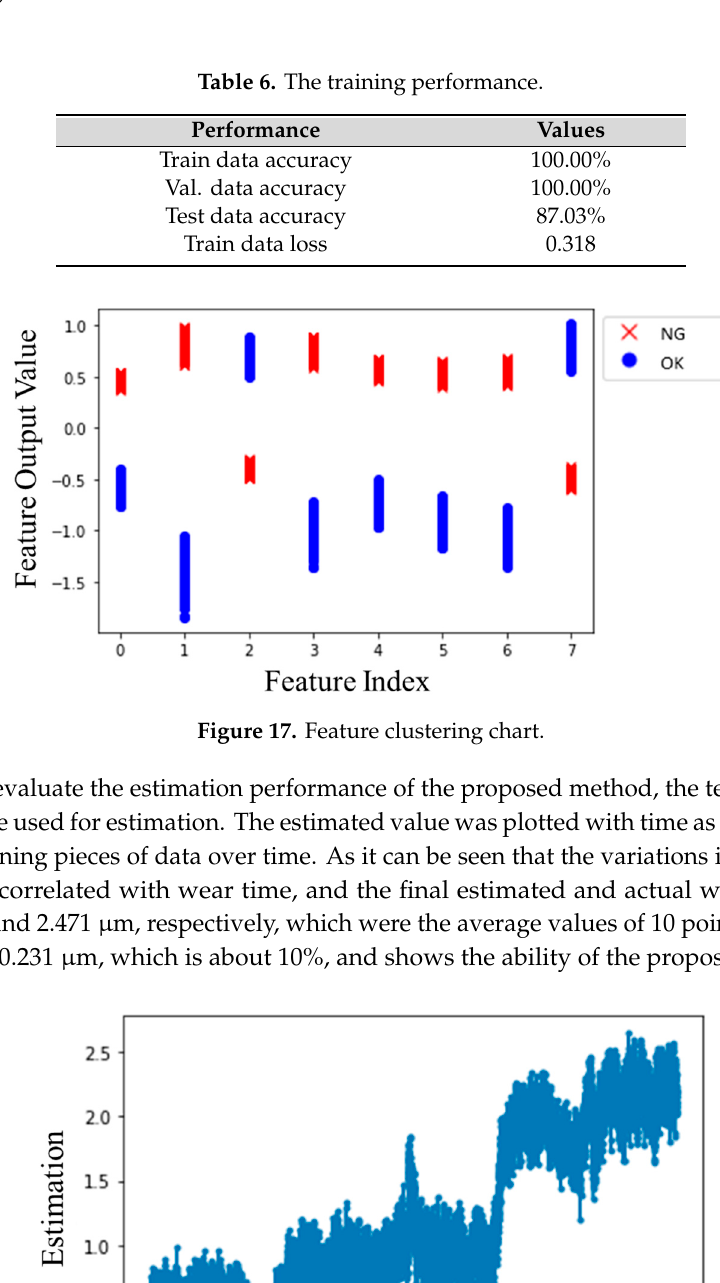
Table 6. The training performance.